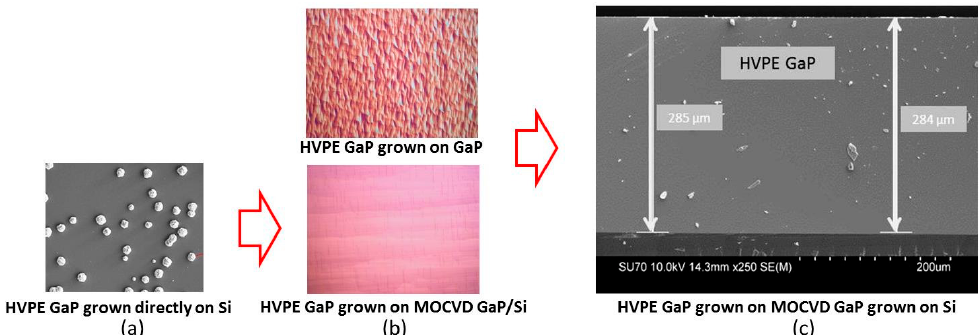
Figure 19. ( a ) HVPE growth of GaP directly on Si (duplicates Figure 13a); ( b ) Nomarski top surface images of a direct homoepitaxial HVPE growth of GaP on a GaP substrate (upper image) and HVPE GaP grown on Metal Organic Chemical Vapor Deposition (MOCVD) GaP/Si; ( c ) SEM cross section of HVPE GaP grown on MOCVD GaP/Si.